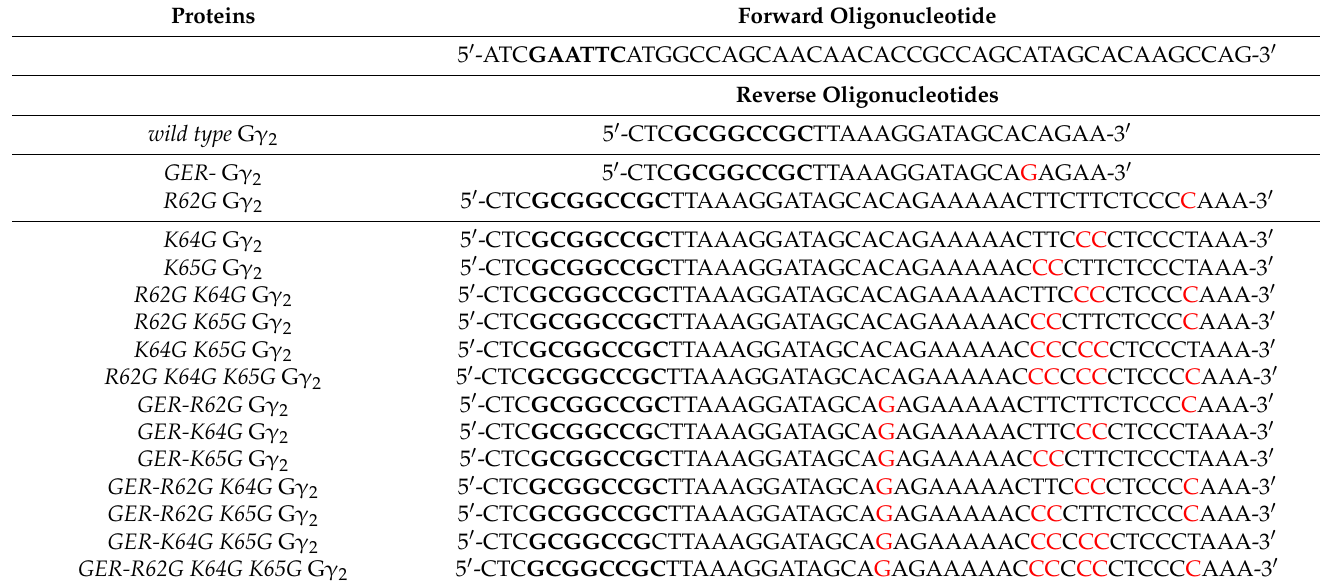
Table 2. PCR primers used and their corresponding amino acid